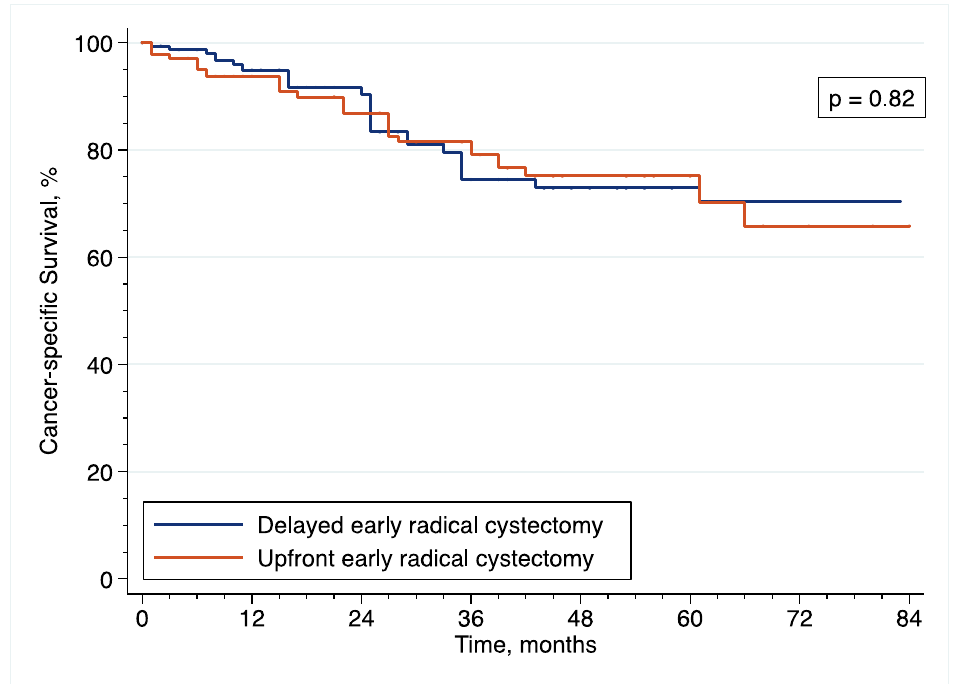
Figure 7. Inverse probability of treatment weighting (IPTW)-adjusted Kaplan–Meier curves that compare the CSS of included patients treated with upfront or delayed eRC for HR-NMIBC.